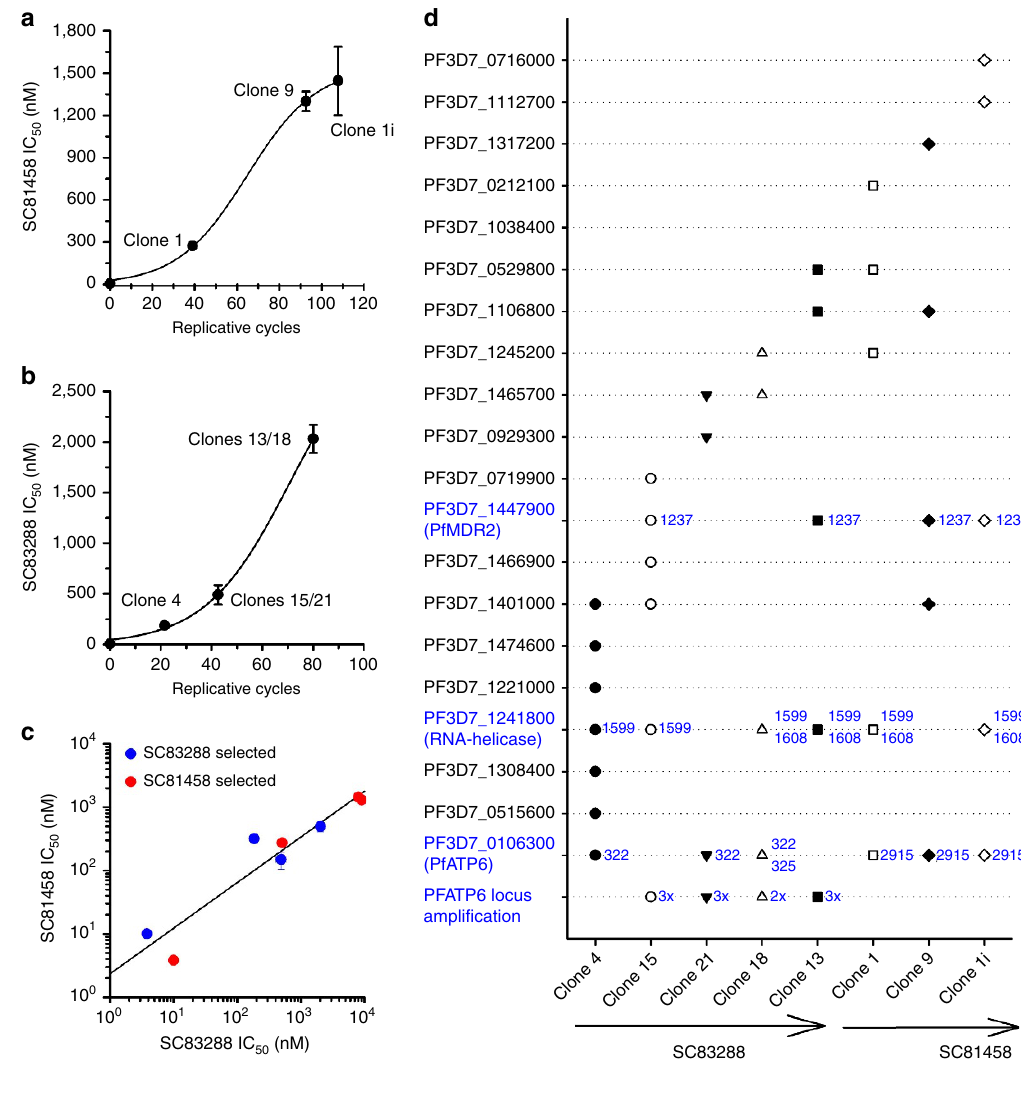
NATURE COMMUNICATIONS|8:15273|DOI: